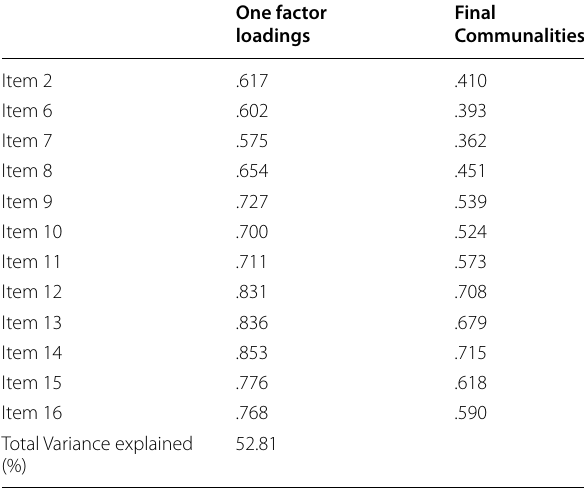
Table 2 Final Principal Axis Factoring (PAF)’s factor loadings and communalities of the final 12‑ item structure of the inventory (n 400) after reduction =